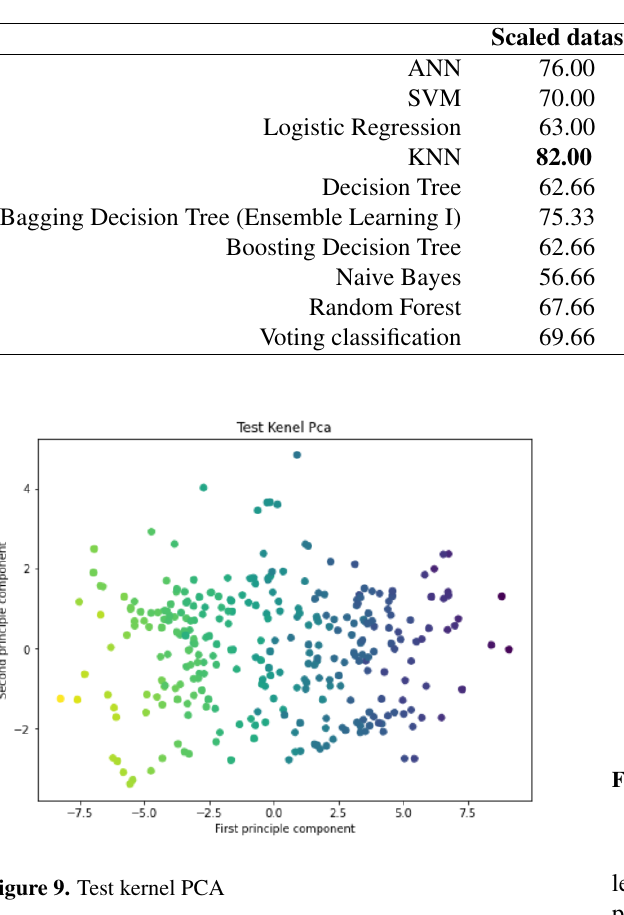
three datasets are applied to 10 di ff erent Machine Learning